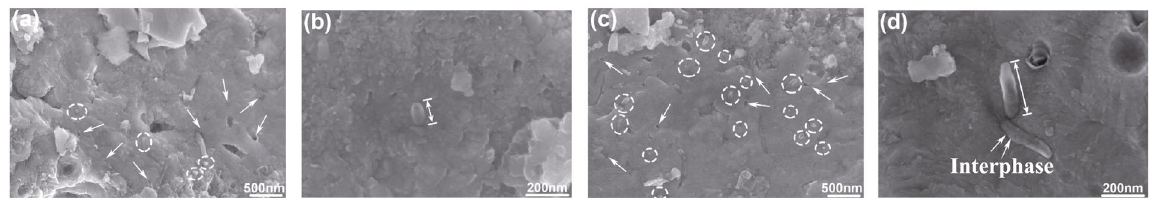
Fig. 5 Typical SEM images of fracture morphologies of (a) and (b) as-grown, (c) and (d) BN-coated BNNTs in matrix. BN interphase was deposited for 20 min. White arrows and circles in the upside images indicate the broken nanotubes left in matrix with brittle fracture mode and the pull-outs of nanotubes, respectively.